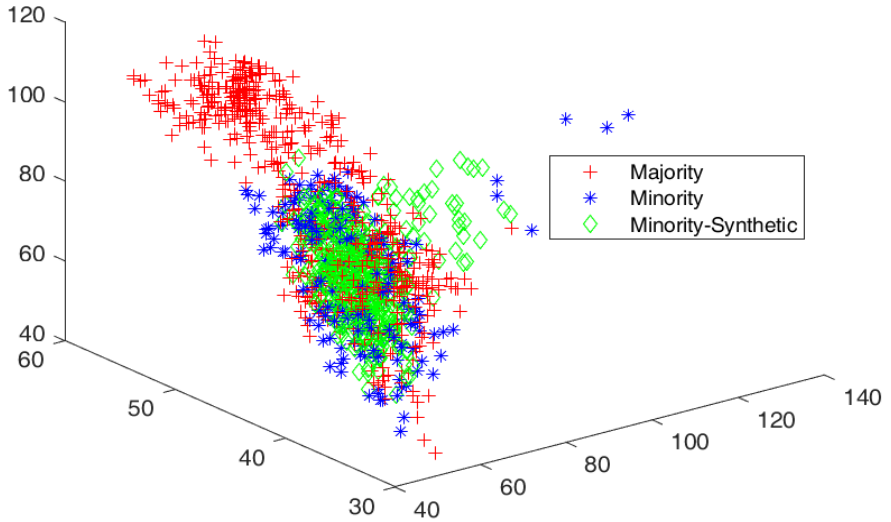
Figure 3. Cluster view of data distribution in cluster among majority and minority for the proposed SMOTE-PSOEV for Pima dataset.